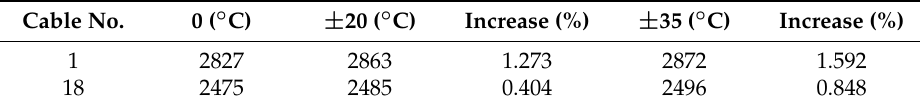
Table 4. Earthquake records used in time history analysis.